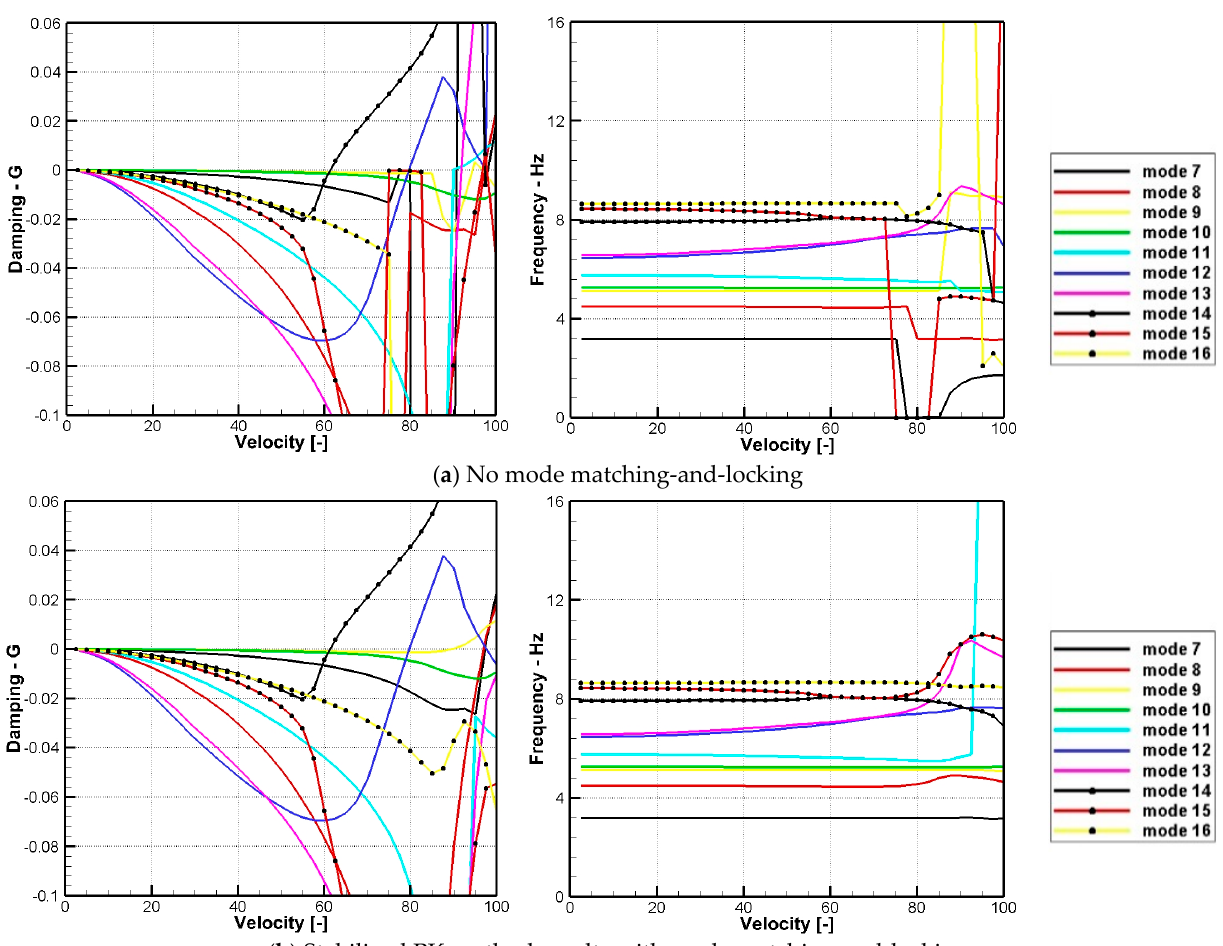
Figure 9. Influence of mode matching-and-locking in the FLUTQ PK-method: damping and frequency diagrams of the Asymmetric 2 configuration of the real-world jet aircraft with velocities arbitrarily normalized.